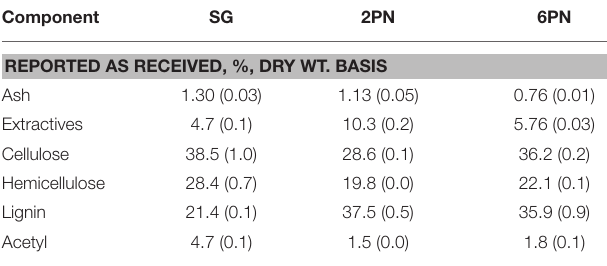
TABLE 2 | Chemical composition of feedstock biomass.